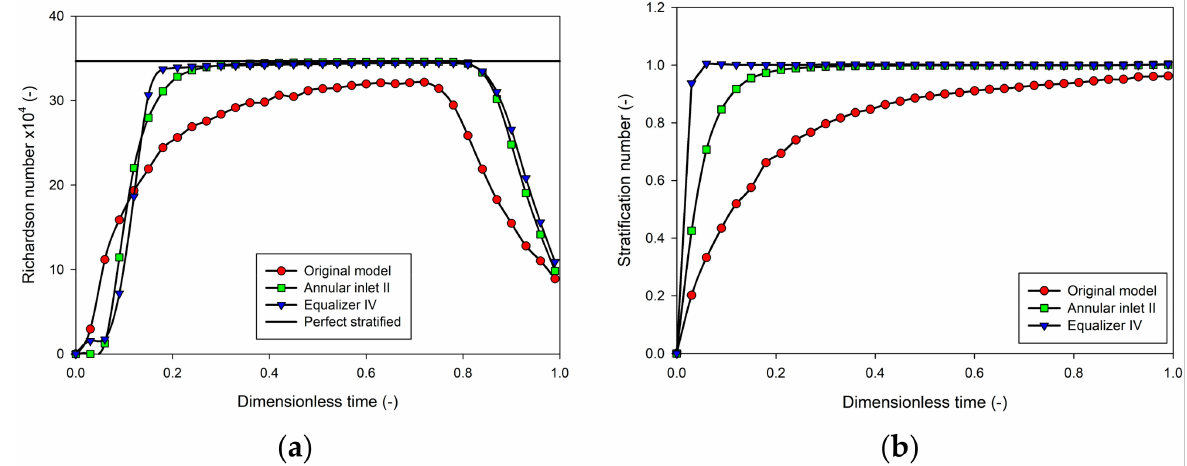
Figure 18. The comparison results of dimensionless term between the annular inlet II and the equalizer IV models: ( a ) the Richardson number; ( b ) the stratification